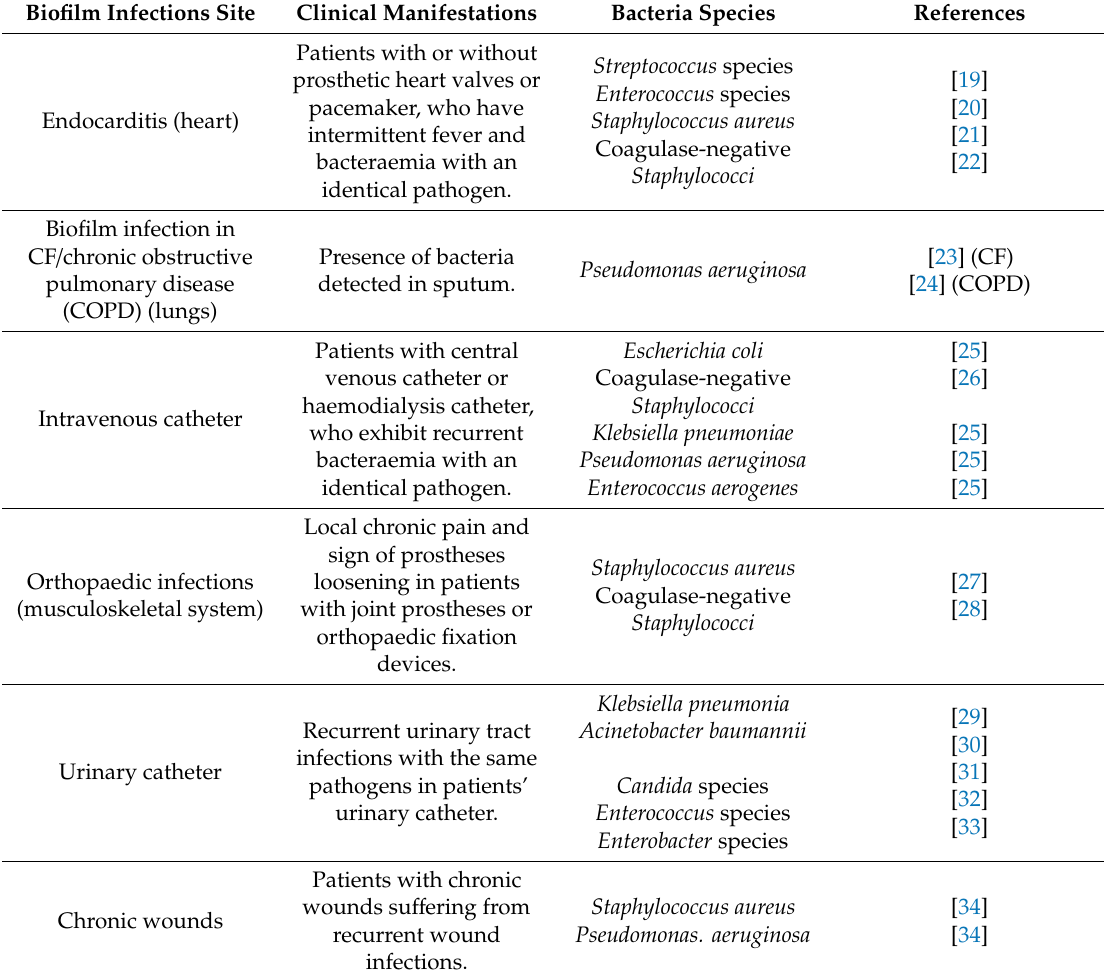
Table 1. Clinical manifestations of biofilm-related infections (mostly ESKAPEE pathogens (Enterococcus faecium., Staphylococcus aureus, Klebsiella pneumoniae, Acinetobacter baumannii, Pseudomonas aeruginosa, Enterobacter spp. and Escherichia coli)